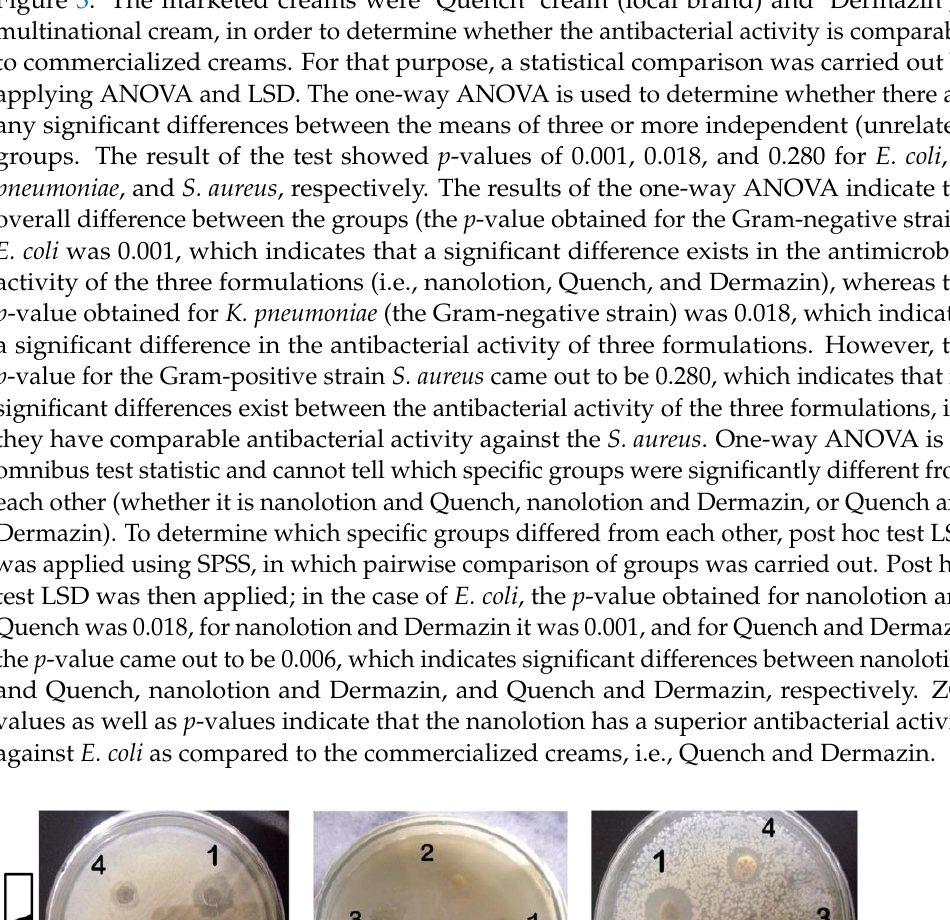
Figure 3. ( A ). In vitro antibacterial comparison of (1) nanolotion in DMSO, (2) nanolotion in water, (3) Quench cream, and (4) Dermazin cream of, ( a ) E. coli , ( b ) K. pneumoniae , and ( c ) S. aureus . ( B ). Comparison of In vitro anti-bacterial ZOI (mm) of (1) nanolotion in DMSO (2) nanolotion in water (3) Quench cream (4) Dermazin cream of, ( d ) E. coli , ( e ) K. pneumoniae , and ( f ) S. aureus . The p -values obtained for nanolotion and Quench, nanolotion and Dermazin, and Quench and Dermazin were 0.104, 0.004, and 0.005, respectively, when K. pneumoniae was used as a bacterial strain. These values showed that no significant differences exist between the nanolotion and Quench, and a significant difference exists between the nanolotion and Dermazin and Quench and Dermazin. Thus, it can be concluded that nanolotion and Quench have a comparable antibacterial activity against K. pneumoniae , and this antibacterial activity is superior to Dermazin. When the Gram-positive strain S. aureus